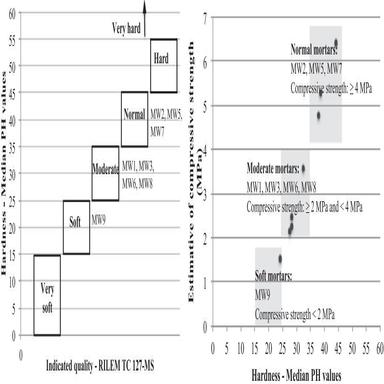
Classification of the mortars according to RILEM TC 127-MS based on median PH values (a) and relation between the mortars' classification and the estimative of the compressive strength using the function proposed by Ferreira Pinto et al. (b).